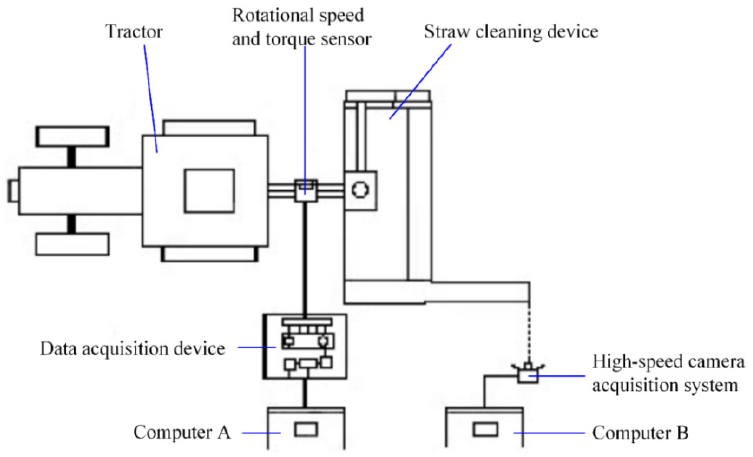
Figure 3. The installation method of testing device.